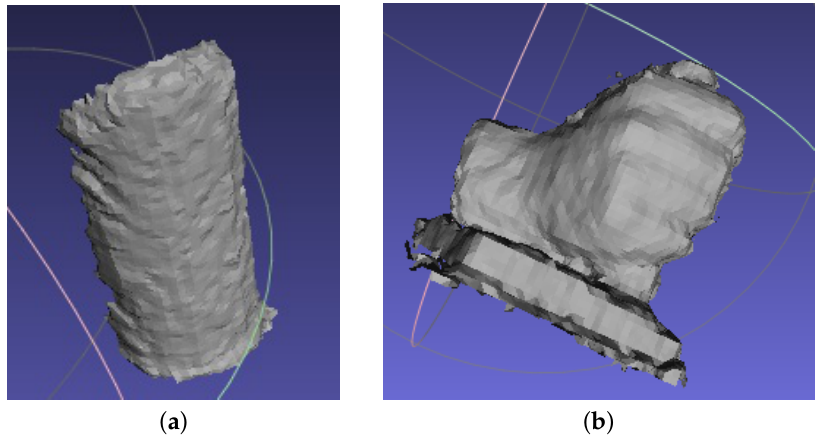
Figure 10. 3D measurement with Kinect. ( a ) Cylinder and ( b ) hand surfaces measured with the Meshlab